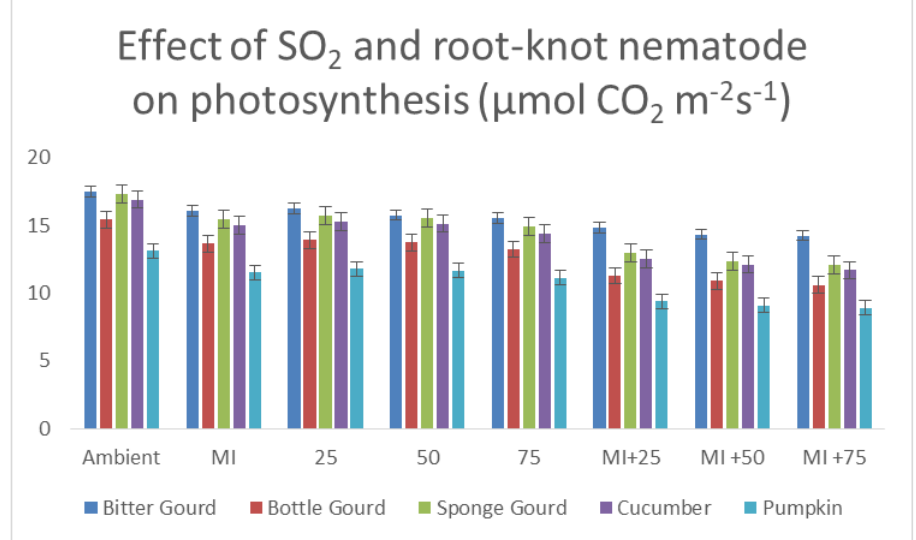
Figure 10. Bar diagram showing the effect of SO 2 exposure and root-knot nematode inoculation on the rate of photosynthesis of five cucurbits. Table 5. Effect of intermittent exposures of SO 2 and root-knot nematode (M. incognita) inoculation on physiological parameters of five cucurbits.